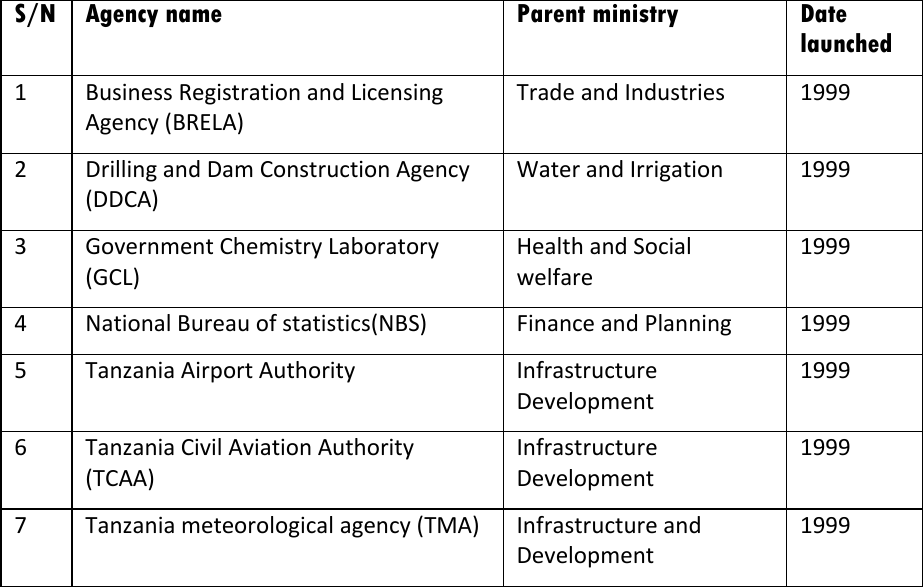
Figure 1: Executive Agencies landscape in Tanzania as of 2008